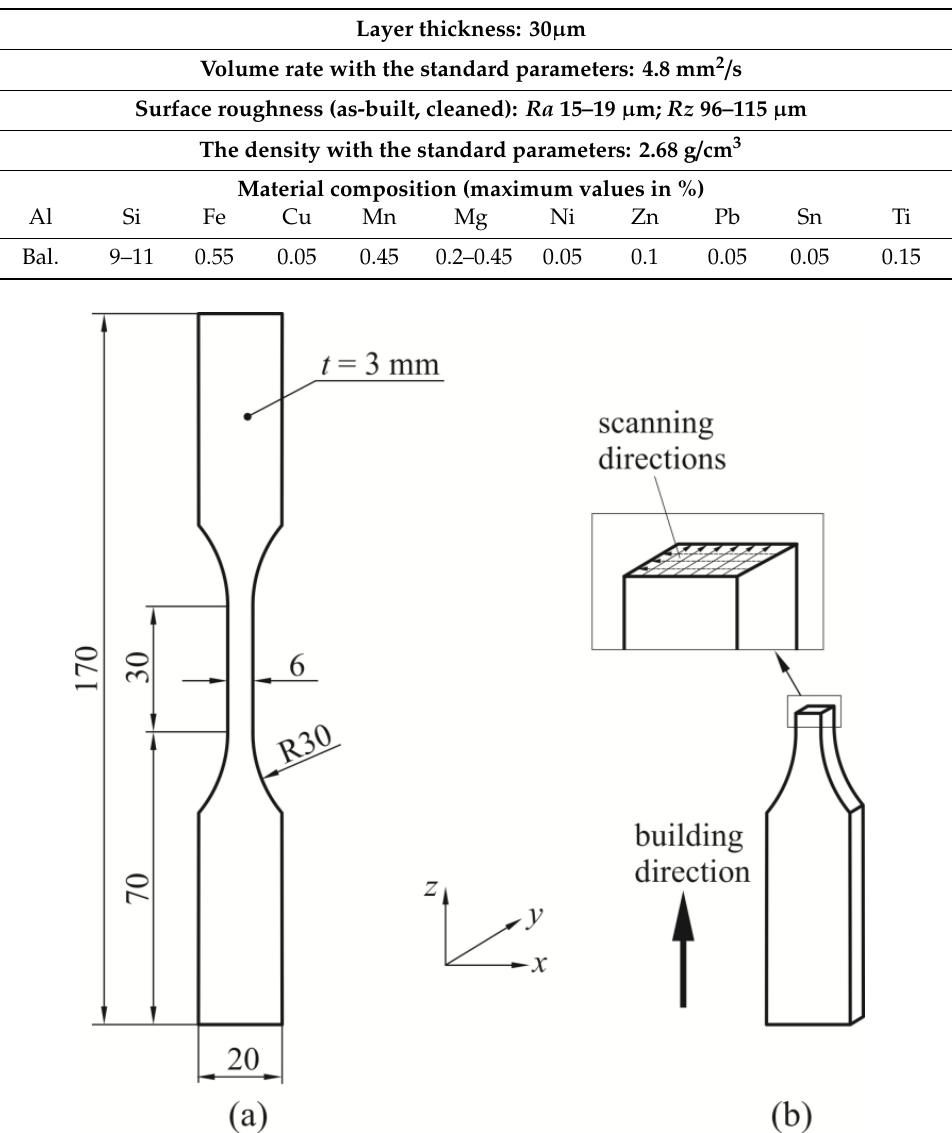
Figure 4. Geometry ( a ) and building direction ( b ) of a flat specimen. (all dimensions are in millimetres [mm]).